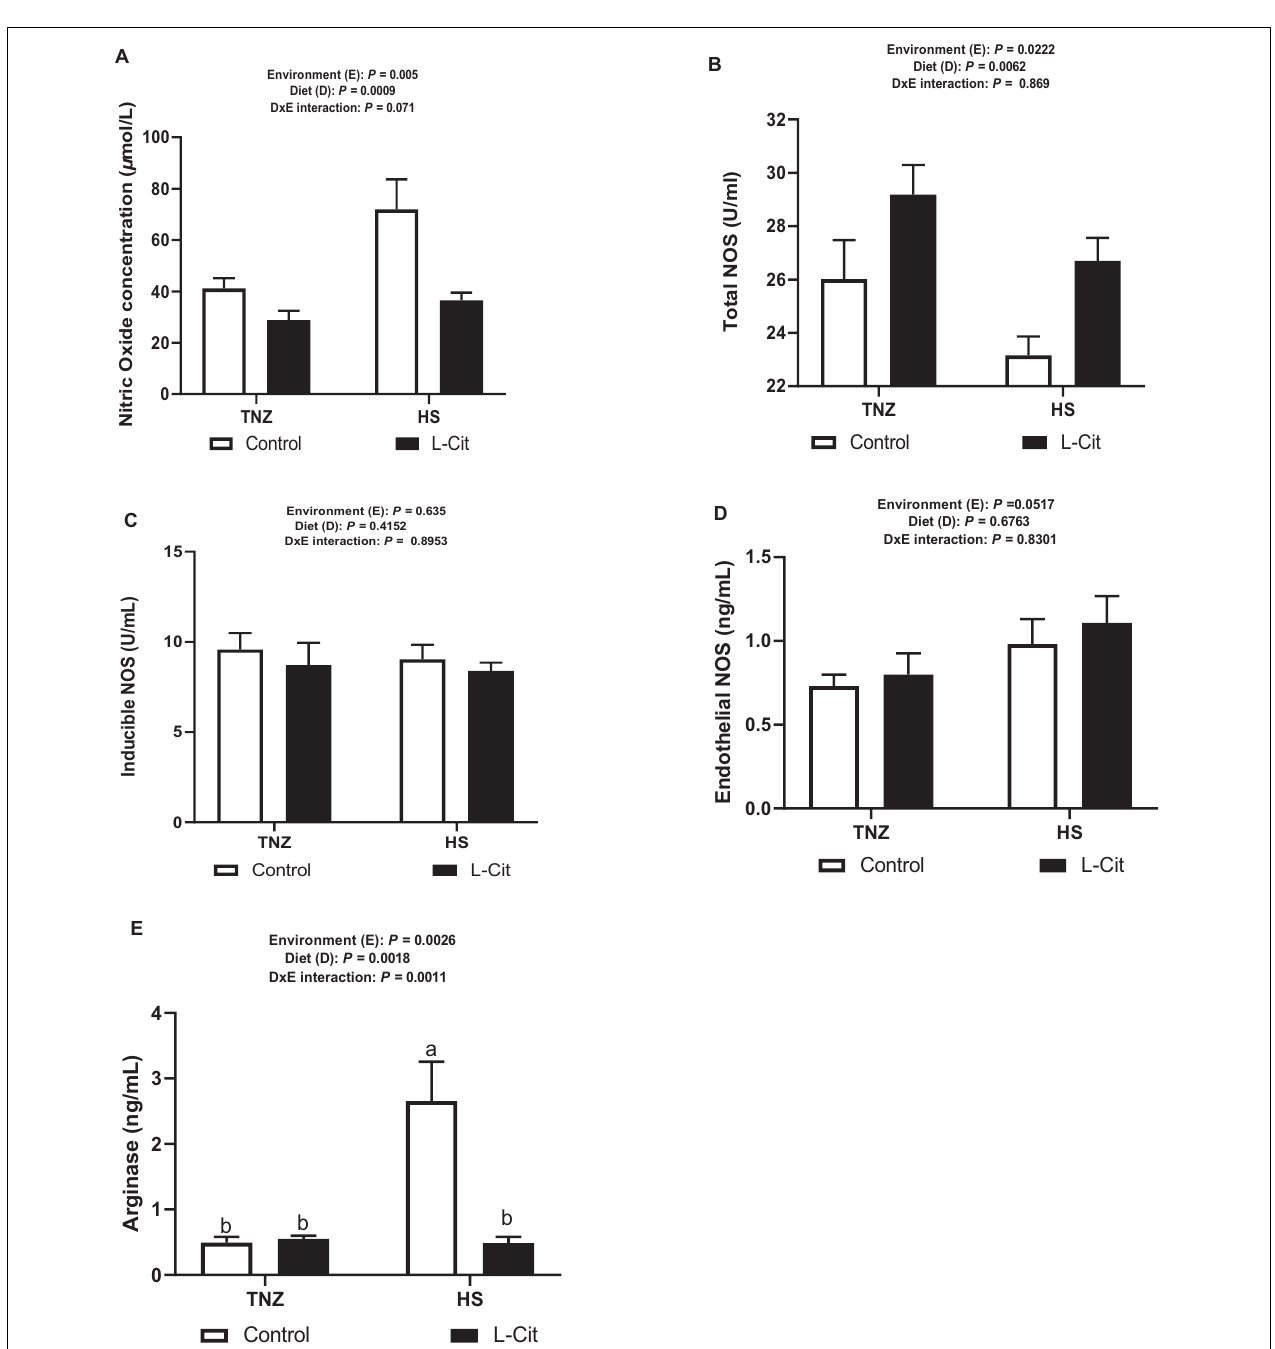
FIGURE 5 | Effect of heat stress and L -citrulline supplementation on nitric oxide production during acute heat stress. (A) NO concentration. (B) Total NO synthase activity. (C) Inducible NO synthase activity. (D) Endothelial NO synthase activity. (E) Arginase activity. Data are presented as mean ± SEM ( n = 8). a , b Different letters indicate significant difference of D × E interaction at P <